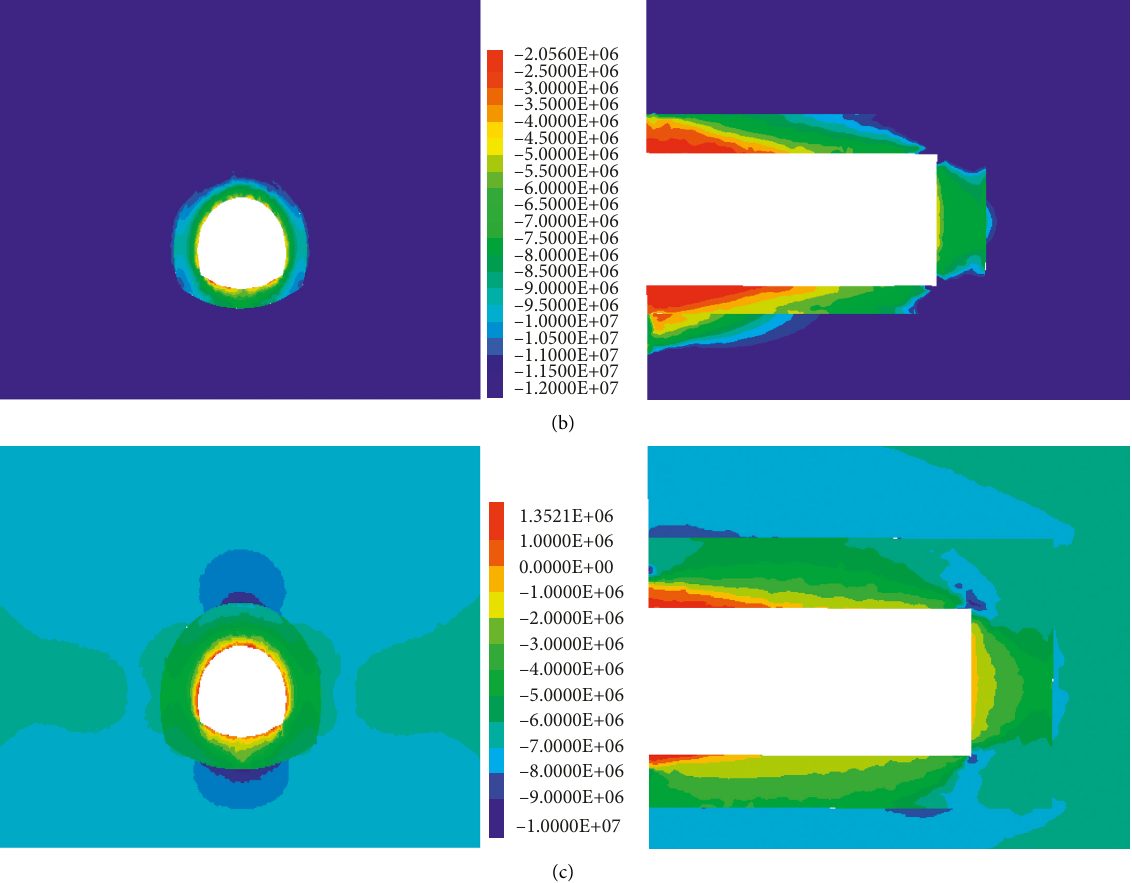
Figure 8: Distribution characteristics of principal stress in the middle of surrounding rock. (a) Tunnel excavation without surrounding rock modification. (b) The modified depth 3 m. (c) The modified depth 5